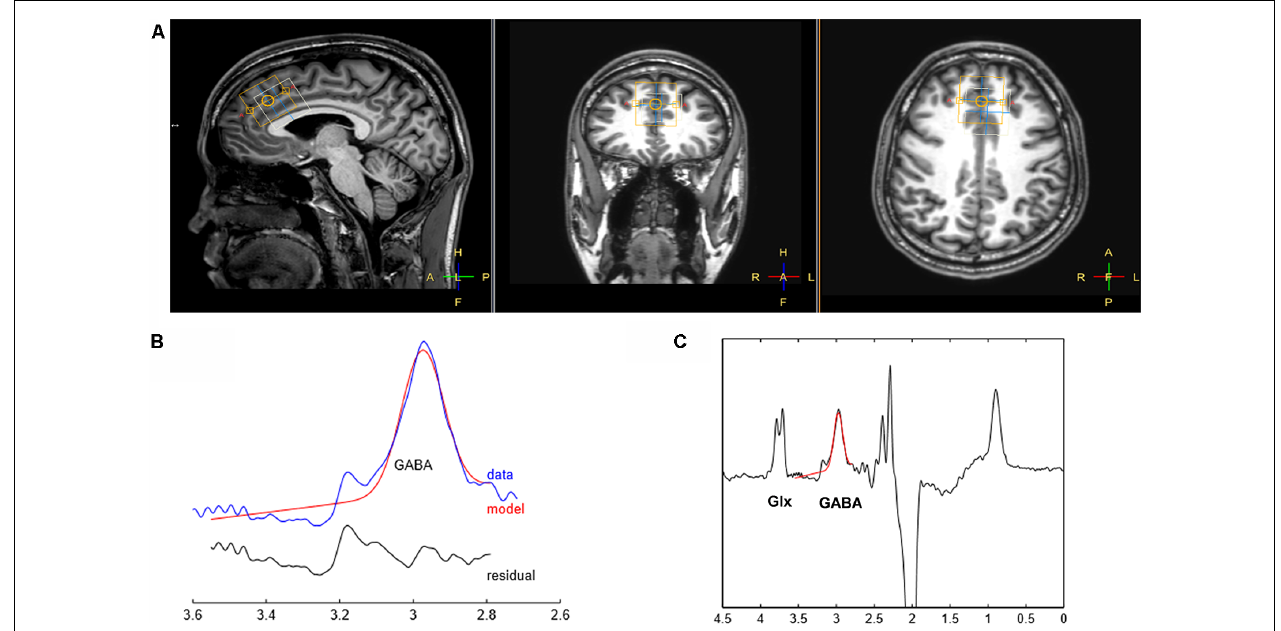
FIGURE 1 | Illustration of voxel placement and sample spectral fitting using Mescher-Garwood point-resolved spectroscopy (MEGA-PRESS). (A) The position of voxels in a T1-weighted image. The yellow box represents the voxel of interest (VOI) for γ -aminobutyric acid (GABA) placed on the prefrontal cortex (PFC; VOI: 3 × 3 × 3 cm 3 ) while the white box depicts the location where the water signal is acquired. (B) The curve-fitting of the GABA peak using Gannet 2.0 toolkit. The red lines in the panels are the best fitted model using a simple Gaussian model of the GannetFit; the blue lines show the GABA-edited spectrum corrected for phase and frequency; the black line represents the residual difference between the curve fit and experimental data, indicated as red and blue lines, respectively. (C) The MEGA-PRESS difference spectrum. The Glx and GABA peaks resonate at 3.7 and 3.0 ppm,